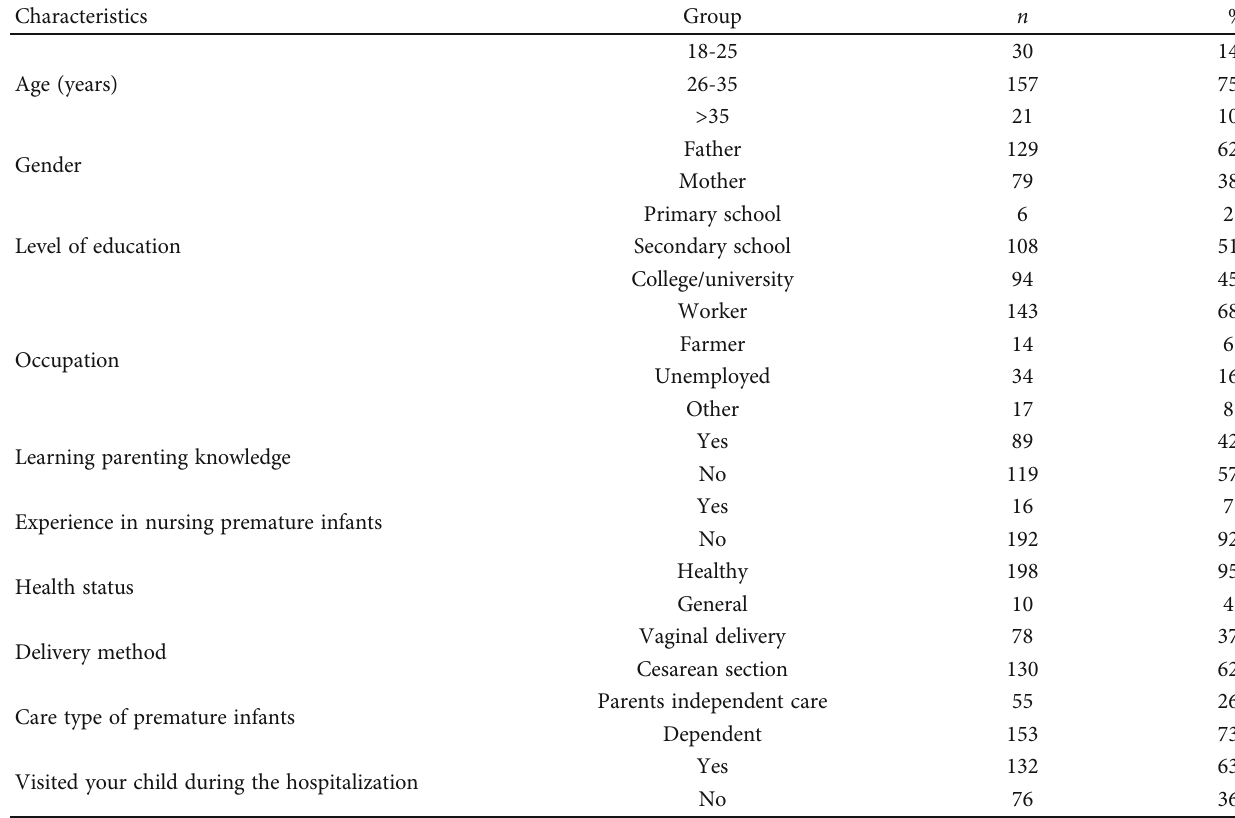
Table 1: Demographic data of parents of premature infants ( N = 208